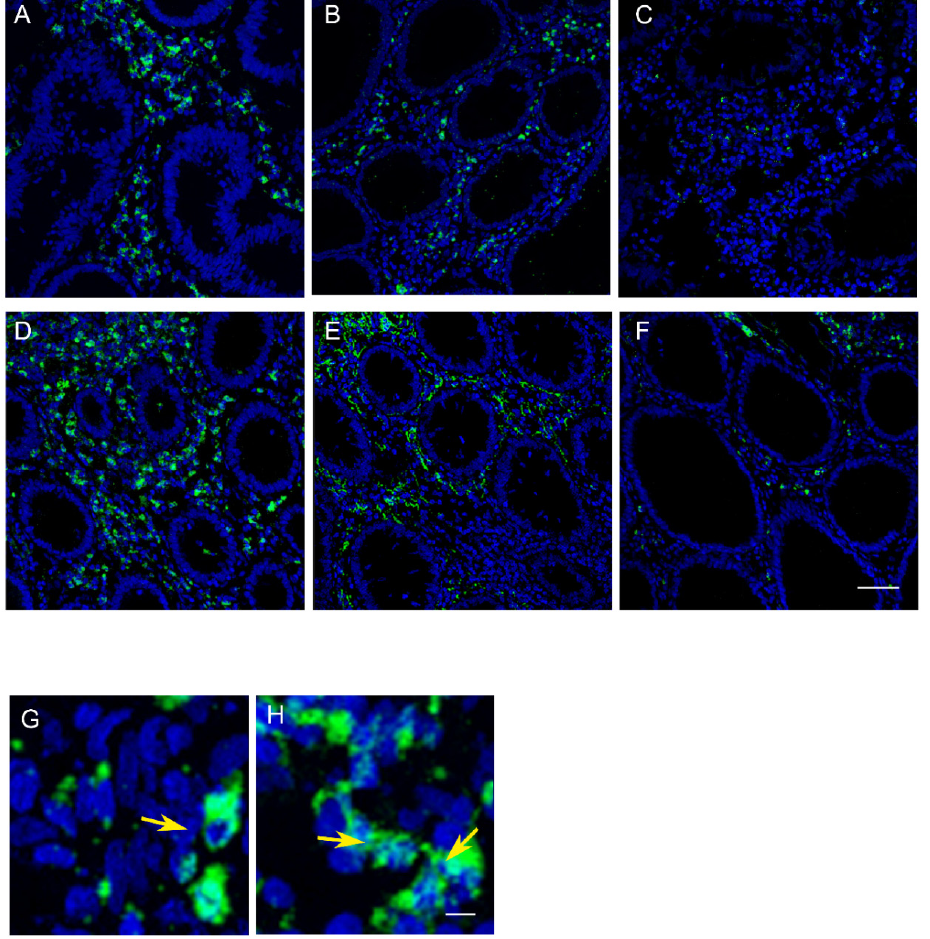
Figure 1. ( A – C ) Section of normal colorectal mucosa labeled with DAPI (blue) and anti- Myeloperoxidase (green) by confocal microscope. ( A ) Right tract of the colon: Many stromal cells distributed among the crypts show marked staining; epithelial cells are unlabeled. ( B ) Left tract of the colon: the staining clearly decreases with respect to the ascending tract. ( C ) Rectum: in this part of the bowel only a few cells are positive for myeloperoxidase labelling. ( D – H ) Section of normal mucosa labeled with DAPI (blue) and anti-MAPLC3 (green) by confocal microscope. ( D ) Right tract of the colon: MAPLC3 protein is localized mainly in stromal cells at the cytoplasmic level; the staining patterns varies from a diffuse mode to a granular one and is very evident ( G ). ( E ) Left tract of the colon: The immunostaining is significantly decreased and the puncta formation of MAP-LC3 in the autophagosome is clearly detectable, especially around the nucleus ( H ). ( F ) Rectum: rare cells spread in the stroma show bright tiny or large aggregates (autophagosomes). Scale bar: 100 µ m for A up to F; Scale bar: 10 µ m for G,